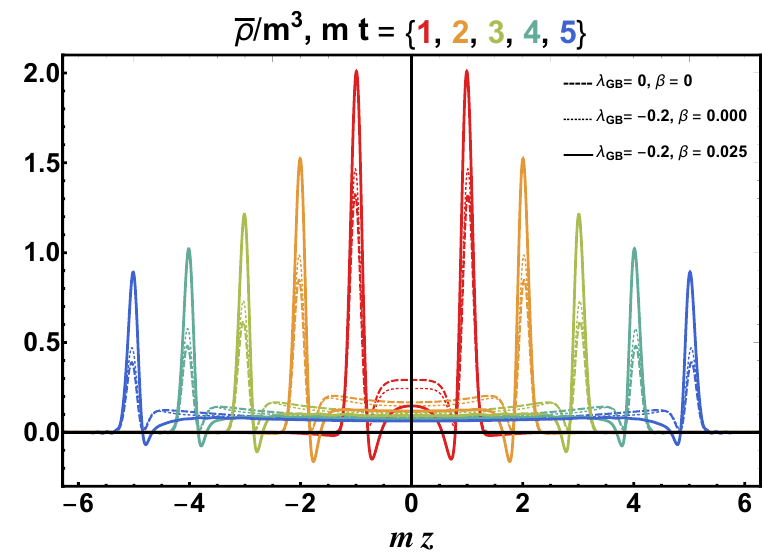
Figure 4 . Time evolution of the baryon number density after the collision of thin sheets with (cid:15) = 0, as in (cid:12)gure 2. Colors denote snapshots in time; di(cid:11)erent line-styles denote di(cid:11)erent values of the